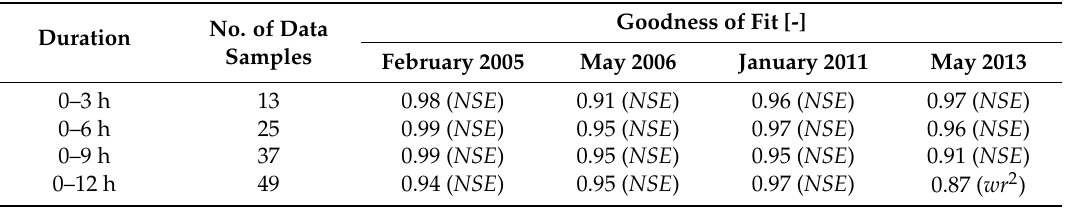
Table 4. Goodness of fit for discharge comparison.